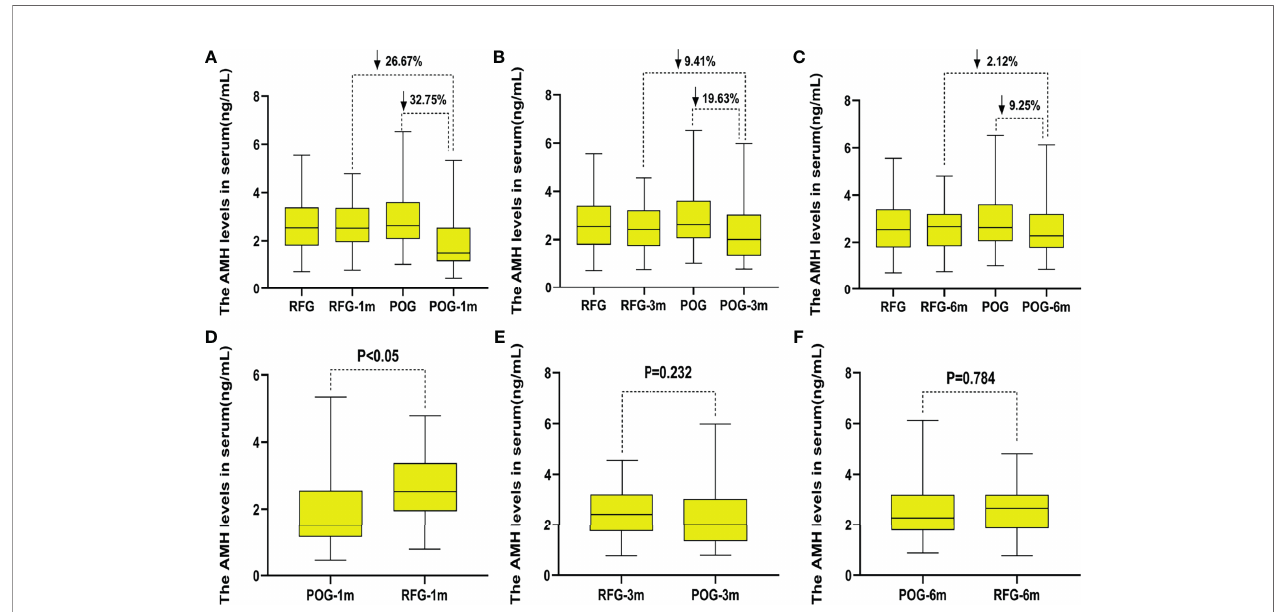
FIGURE 4 | The changes of anti-Müllerian hormone (AMH) levels in the two groups. Compared with preoperative, the decline rate of AMH levels in postoperative observation group (POG) after the fi rst postoperative month was 32.75%. Compared with AMH levels of referent group (RFG), the decline rate of AMH levels in POG after the fi rst postoperative month was 26.67% (A) . Compared with preoperative, the decline rate of AMH levels in POG after third postoperative month was 19.63%. Compared with AMH levels of RFG, the declined AMH level of POG after the third postoperative month was 9.41% (B) . Compared with preoperative, the decline rate of AMH levels in POG after the sixth postoperative month was 9.25%. Compared with AMH levels of RFG, the decline rate of AMH levels in POG after the third postoperative month was 2.12% (C) . Compared with AMH levels of RFG, the AMH levels of POG signi fi cantly declined in the fi rst postoperative month {1.88 ng/ml [interquartile range (IQR), 1.61 – 2.16 ng/ml] vs . 2.57 ng/ml (IQR, 2.32 – 2.83 ng/ml); F = 13.43, p = 0.000} (D) . The AMH levels showed no signi fi cant difference in POG in the fi rst, third, and sixth month when compared with that in RFG (p = 0.232, p = 0.784, respectively) (E, F)